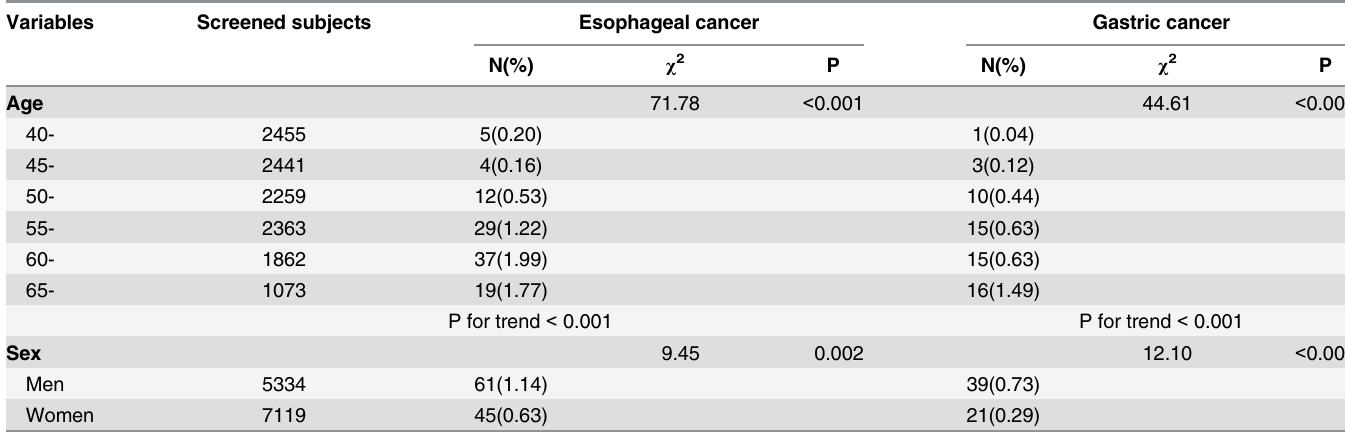
Table 3. Cancer detection rates stratified by age and sex.